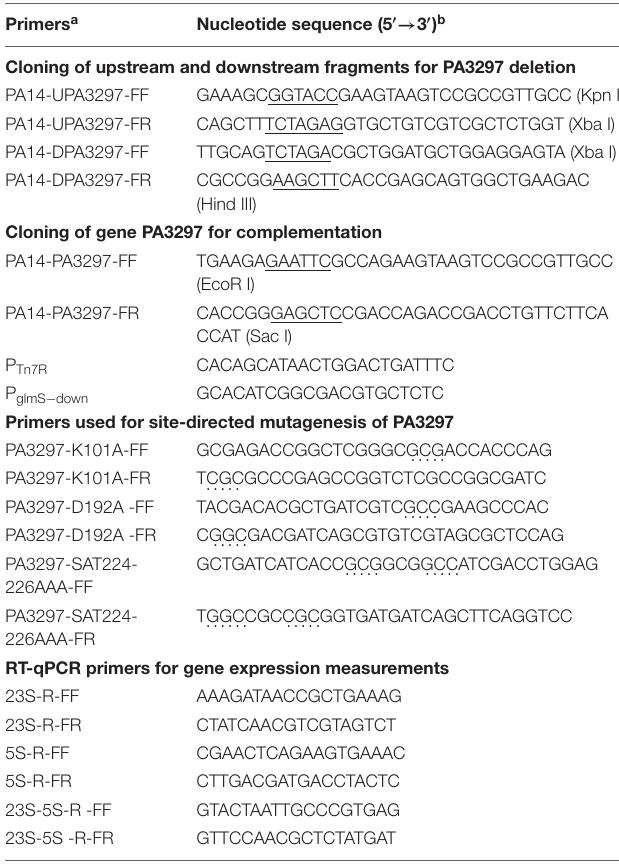
TABLE 2 | Primers used in this study. Primers